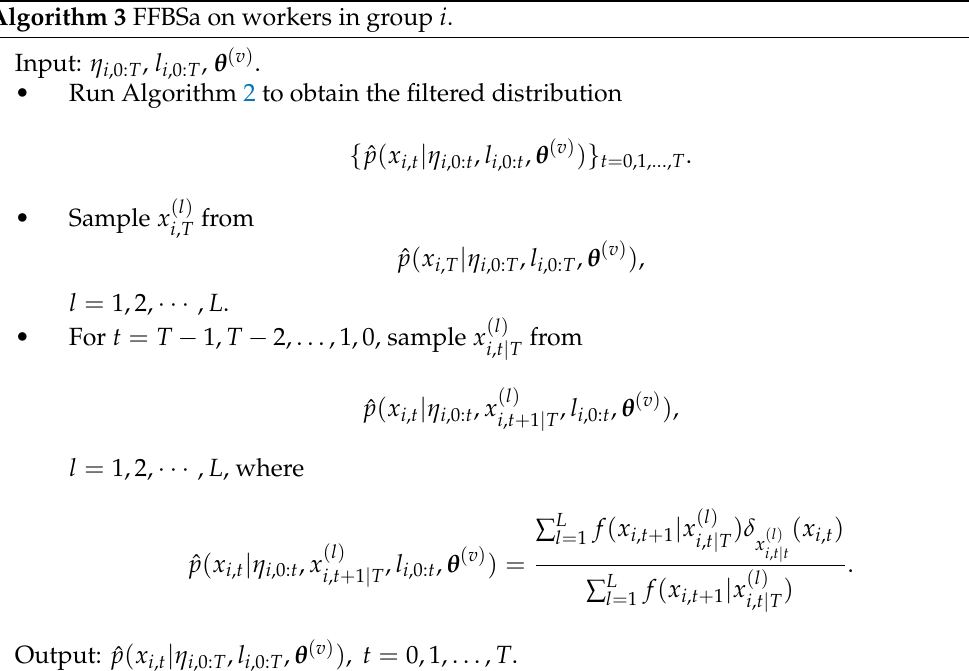
Algorithm 3 FFBSa on workers in group i